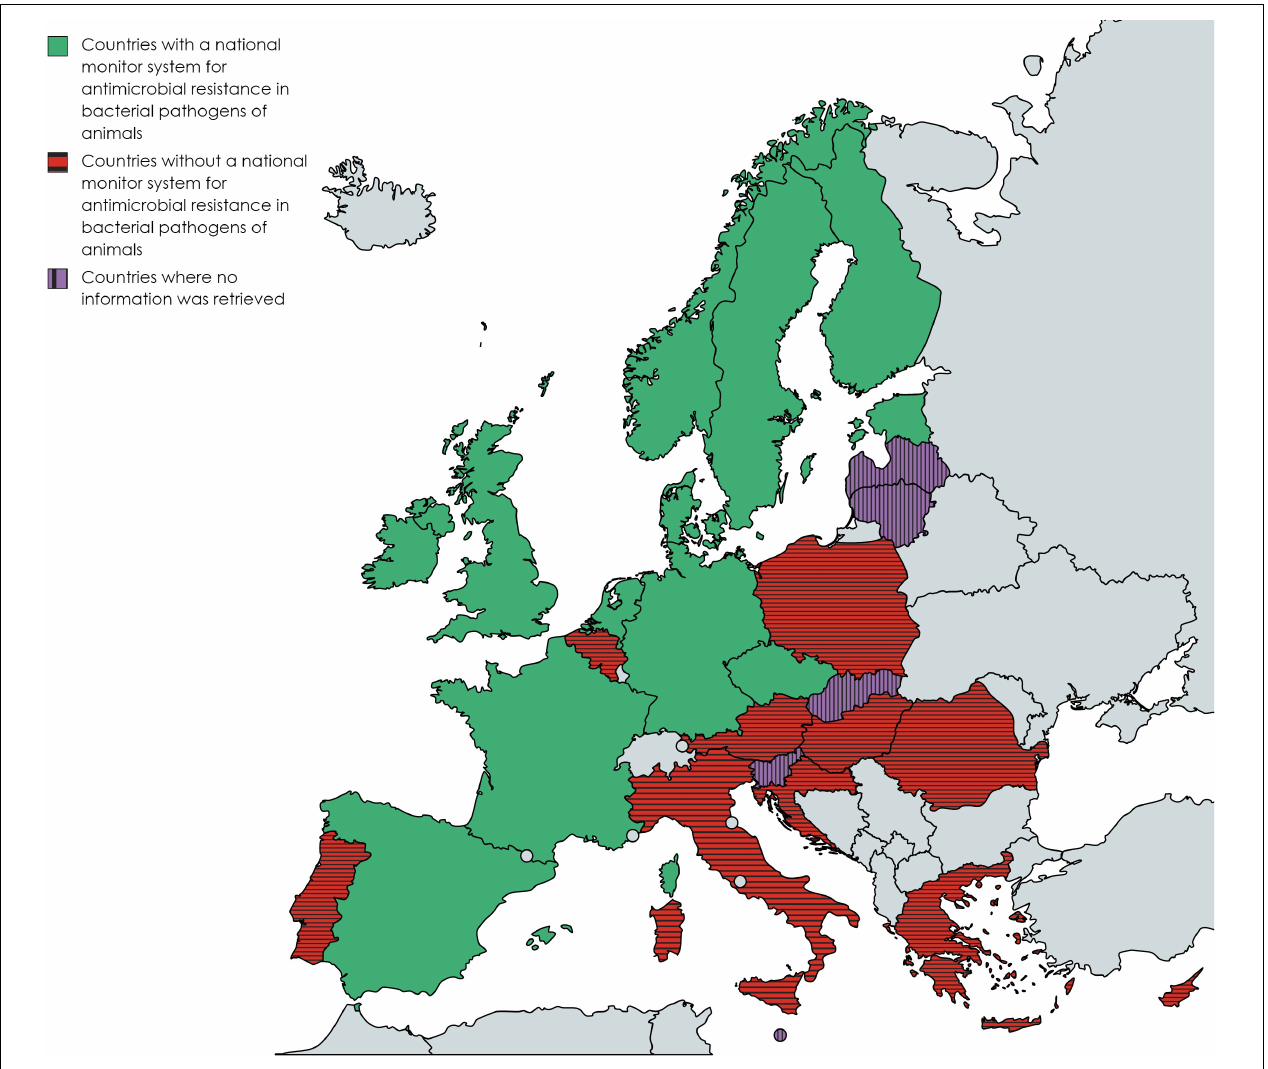
FIGURE 1 | Map of Europe showing the countries that have at least one national monitoring system for antimicrobial resistance in bacterial pathogens of animals, do not have no such system, or where information was missing, among countries affiliated to the European Union Joint Action on Antimicrobial Resistance and Healthcare Associated Infections (EU-JAMRAI) and as of 2020. Created with